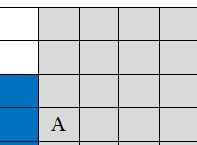
Figure 2. Change of prediction mode diagram, ( a ) is the prediction mode in the marching direction, ( b ) is our prediction mode through structural elements. It used the red color data to predict the green unknown data.